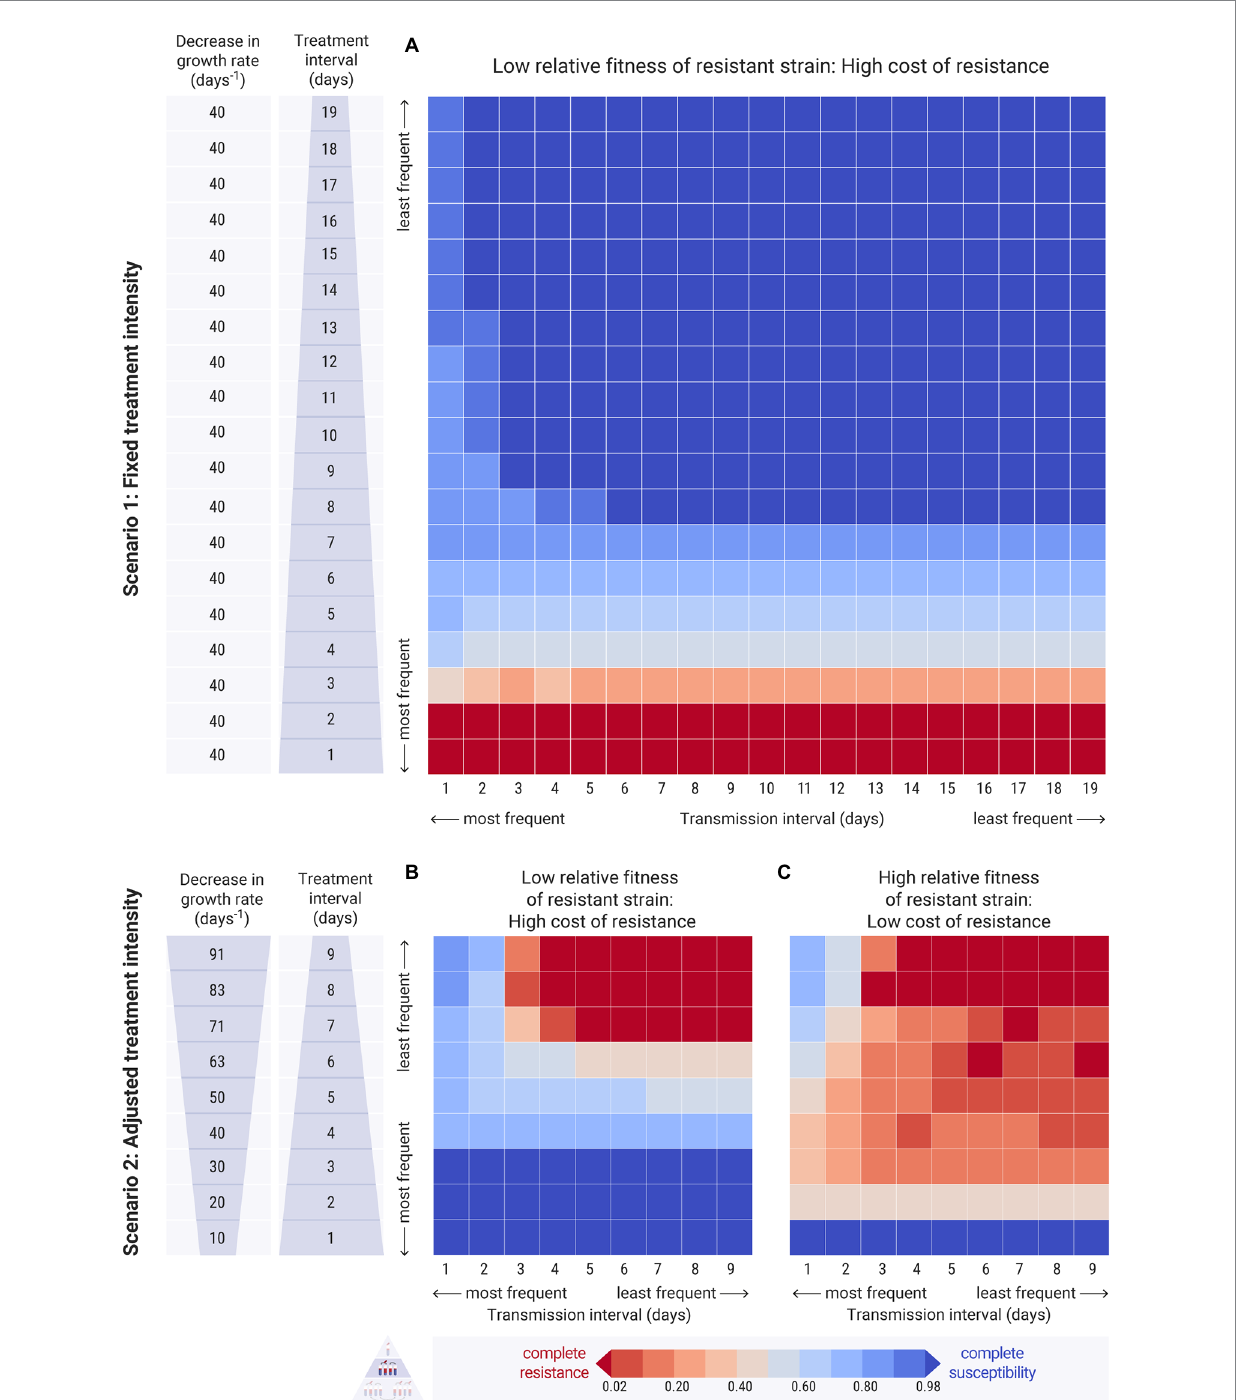
FIGURE 5 Results of the between-hosts simulations across different treatment intervals ( I antim , y-axis) and transmission intervals ( I trans , x-axis). Each cell of the heatmap represents the equilibrium values of one experiment. The colour bar represents the average equilibrium ratio of susceptible bacteria in the host population. (A) Scenario 1, where the decrease in the intrinsic growth rate due to the antimicrobial treatment is fixed across experiments at 40 d Smax = day − 1 . The relative fitness of the resistant strain is set to a low level, at 0.7 w = , indicating a high cost of resistance. For the results on 0.7 w < refer to Supplementary Figures 4, 8 (B , C) Scenario 2, where the decrease in the growth rate due to the antimicrobial, d Smax , is adjusted by the treatment interval, and takes values between 10 and 91 day − 1 (see Supplementary Table S1 for calculation). (B) The relative fitness of the resistant strain is set to a low level, at 0.7 w = , indicating a high cost of resistance. (C) The relative fitness of the resistant strain is set to a higher level, at 0.8 w = , indicating a lower cost of resistance. For the results on different values of w refer to Supplementary Figure